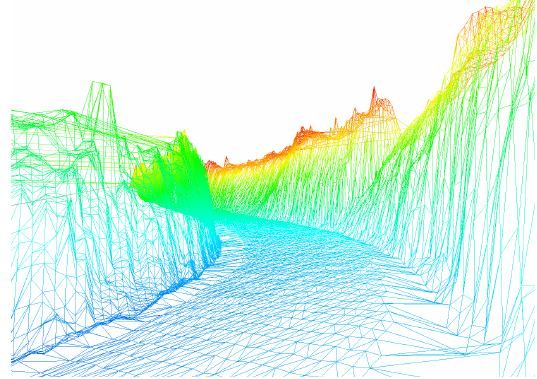
Figure 6: TIN generated from the road point